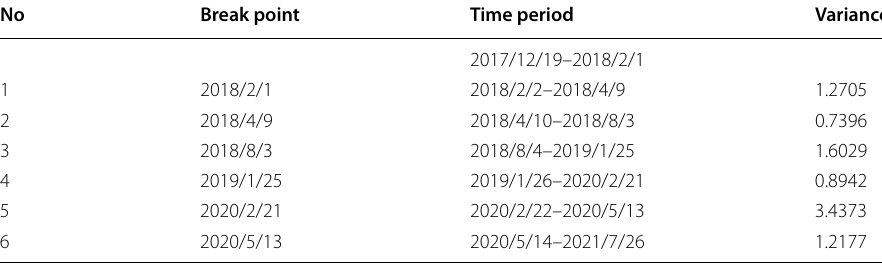
This paper employs the modified version of the ICSS algorithm to detect the structural breakpoints. The specific sample periods are from 2017/12/19 to